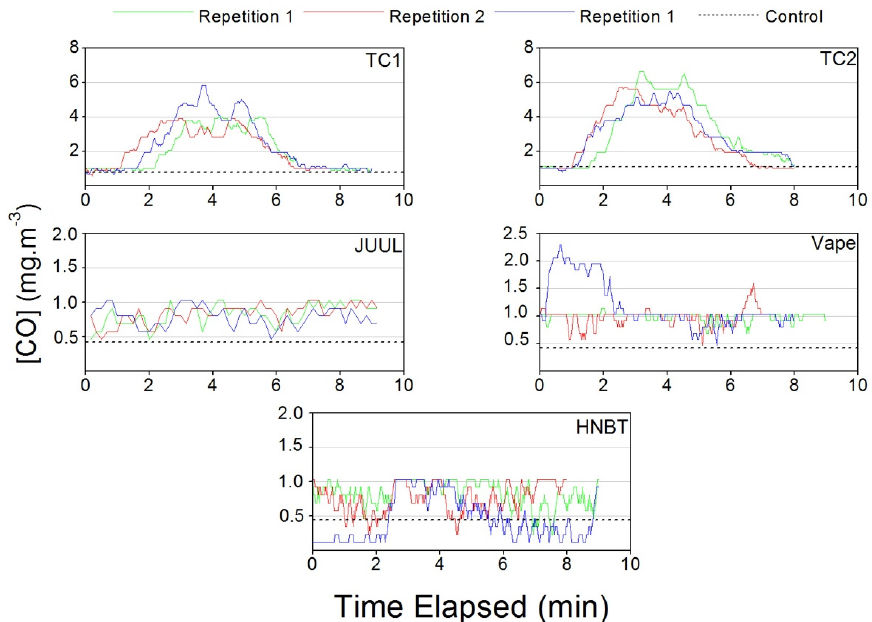
Figure 9. Carbon monoxide concentrations measured in the car during traditional cigarette (TC1 and TC2), e-cigarette (JUUL and Vape) and heat-not-burn tobacco (HNBT) consumption. Northcross et al. [47] measured CO concentrations in cars during the smoking of TCs and obtained an average concentration of 2.8 ± 1.0 mg·m − 3 when all windows were half open, while a study conducted by Dirks et al. [48] measured CO concentrations in vehicles ranging from 0.7 to 3.2 mg·m − 3 , depending on the window conditions and the ventilation setting in the car.